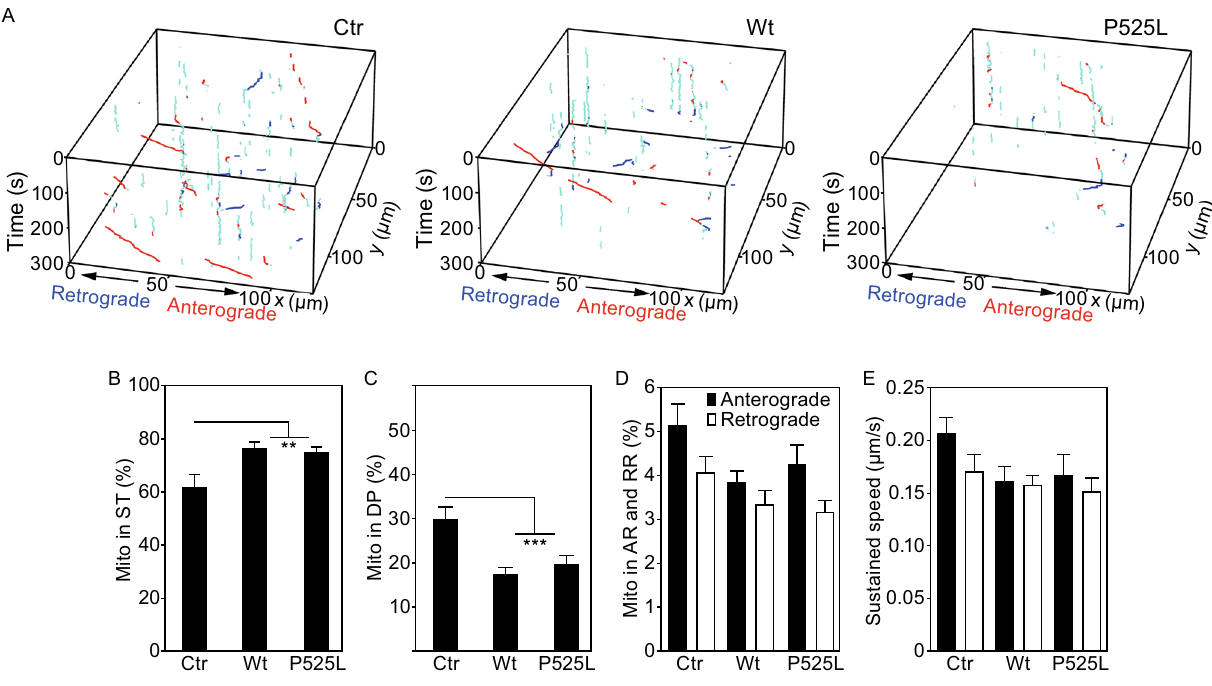
Figure 5. Expression of FUS protein signi fi cantly affects axonal mitochondrial transport in motor neurons of transgenic fl ies expressing FUS. (A and B) A signi fi cant increase in the proportion of mitochondria in stationary (ST) state and a signi fi cant decrease in the percentage of mitochondria in dynamic pause (DP) state in neurons expressing either Wt- or P525L-mutant FUS, as compared with neurons in the control group. (C) The percentage of axonal mitochondria in running states (AR or RR) among different groups. (D) The sustained speed of running mitochondria was determined in different groups of fl ies. At least 20 axonal bundles (containing 100 – 200 axons) were analyzed for each group. Data represent at least 3 independent experiments [one-way ANOVA, (* P < 0.05; ** P < 0.01; *** P <